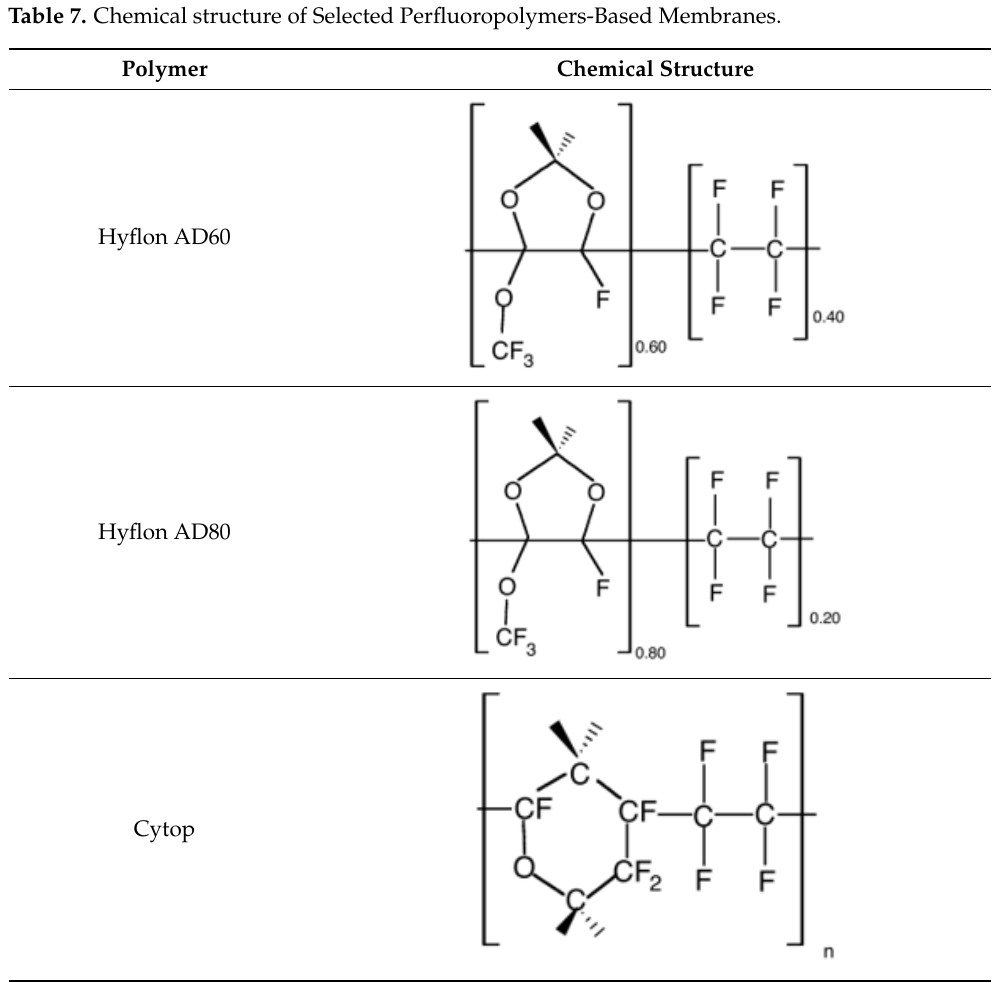
Figure 16. N 2 /CH 4 separation performance for TR polymers ( ● ), PIMs ( ■ ), Perfluoropolymers ( ◆ ) [23].